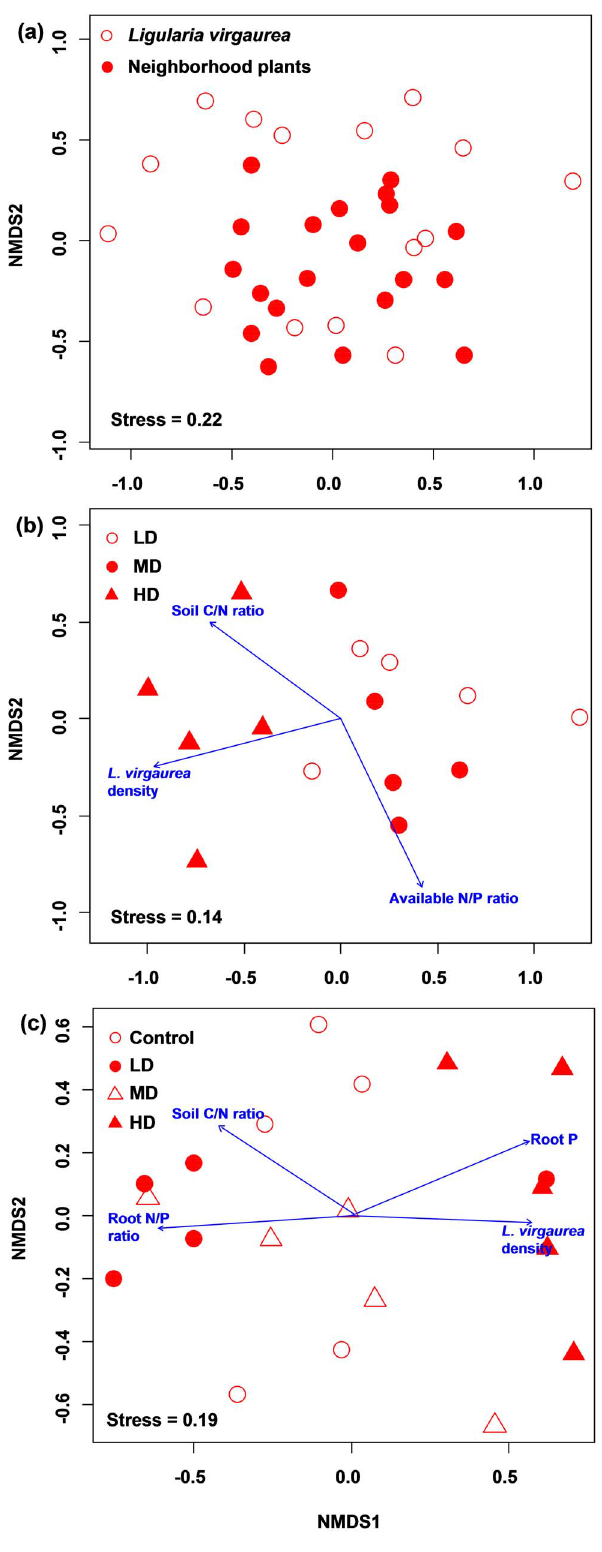
Figure 1. Nonmetric multidimensional scaling (NMDS) ordina- tion of AM fungal communities between Ligularia virgaurea roots and neighborhood plant roots (a), in L.virgaurea roots (b) and in neighborhood plant roots (c) based on Bray-Curtis dissimilarity. Plant properties and soil characteristics were fitted as